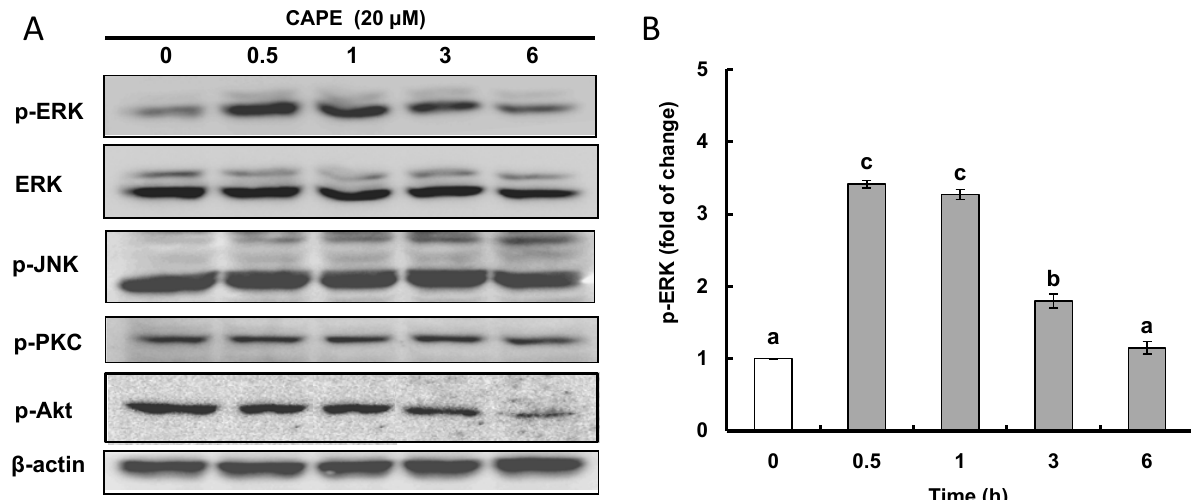
Figure 4. CAPE activates ERK (extracellular signal-regulated kinase) protein